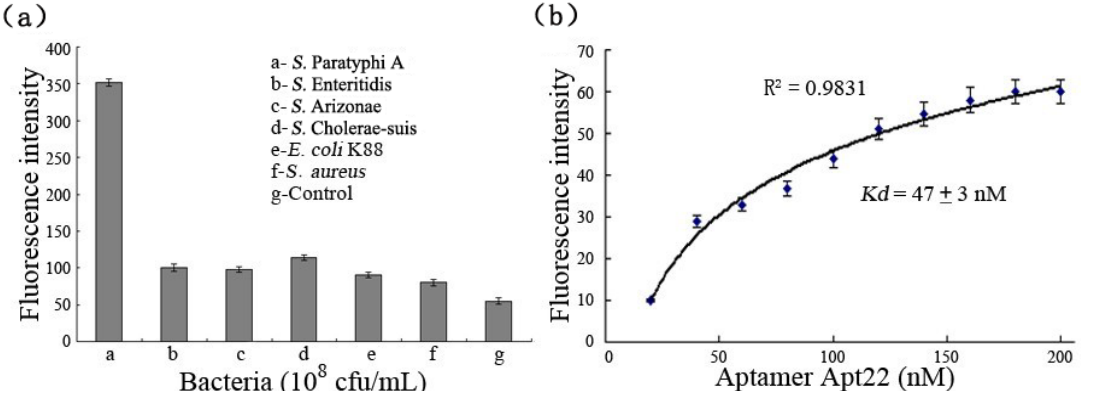
S. Arizonae , E. coli K88, and S. aureus (10 8 cfu/mL) bound to FITC-labeled